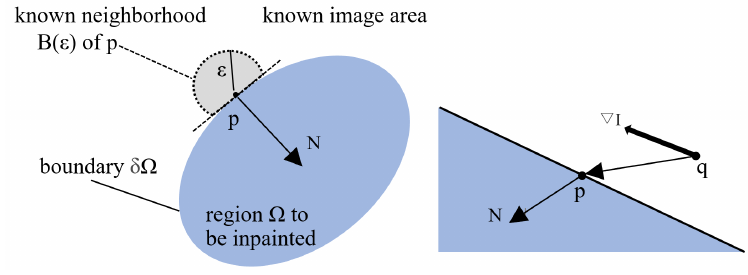
Figure 1. FMM process.